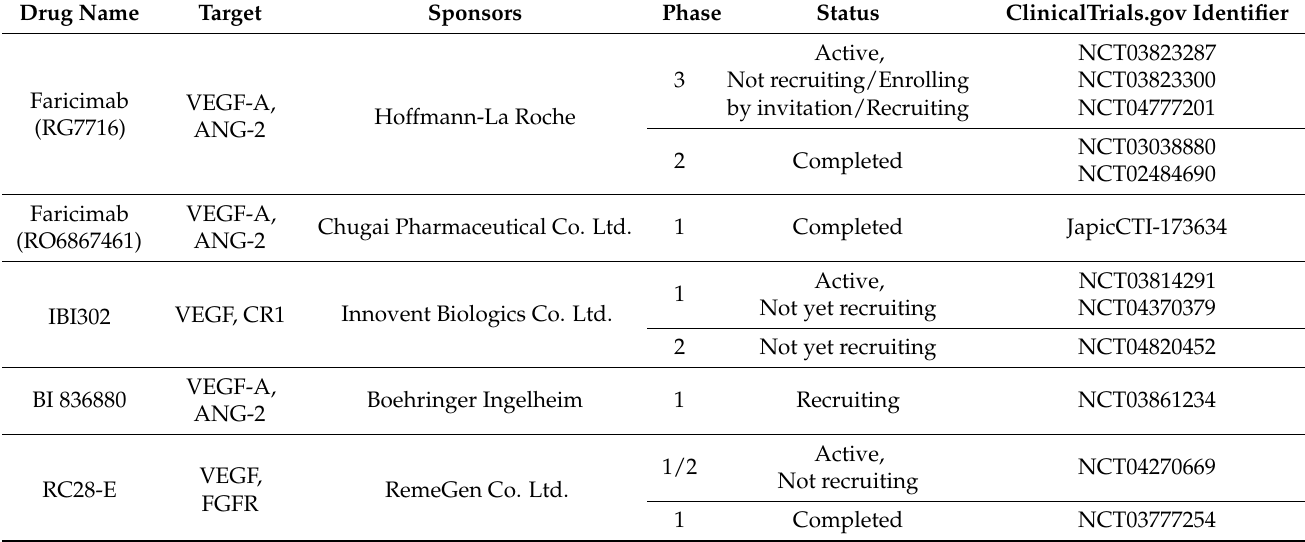
Table 2. Bispecific antibodies for AMD therapy